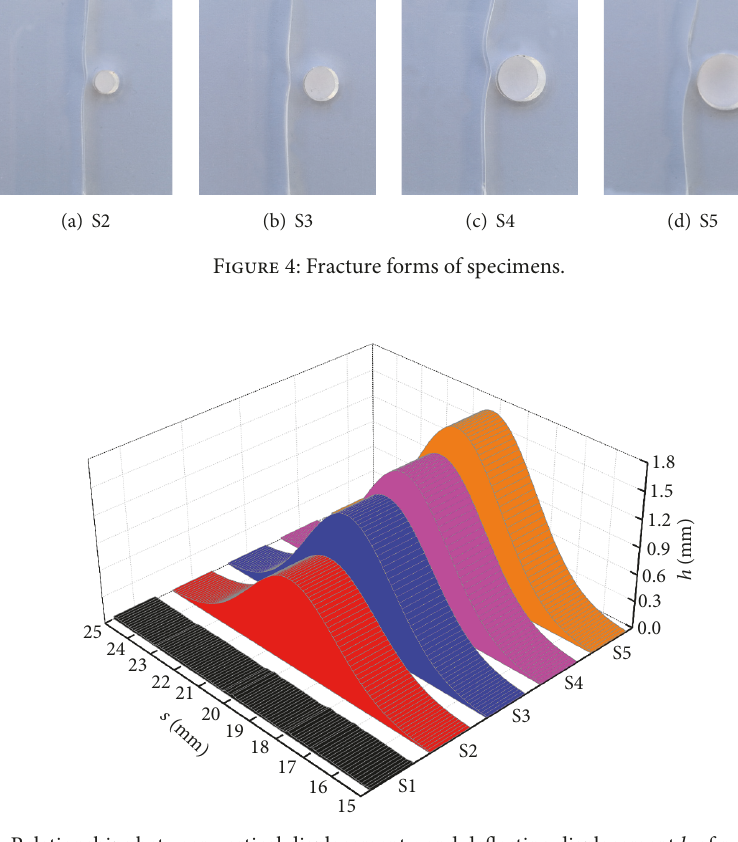
Figure 5: Relationships between vertical displacement 𝑠 and deflecting displacement ℎ of running